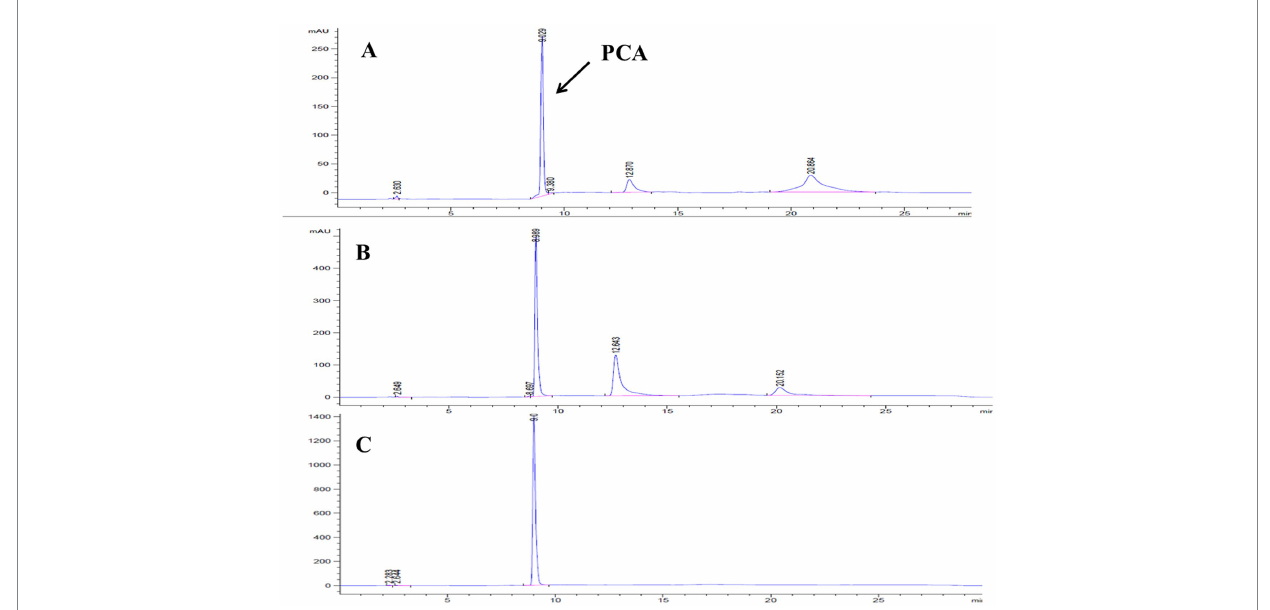
FIGURE 4 HPLC detection of fermentation broth of different strains. (A) Pseudomonas chlororaphis Lzh-T5. (B) Pseudomonas chlororaphis LDPCA-1. (C) Pseudomonas chlororaphis LDPCA-1.